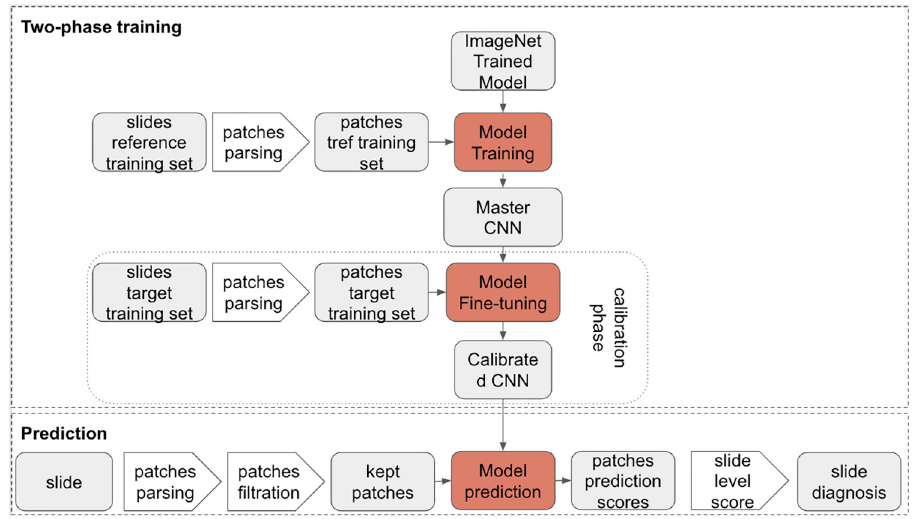
Fig 4. Development of the deep learning model using two-phase training. This figure illustrates how the IC classifier models are plugged into the WSI processing pipeline. Any classifier can be plugged into the pipeline. When implemented in a target center, the plugged model is calibrated on the target center training set, using the master CNN model as a starting state for training.